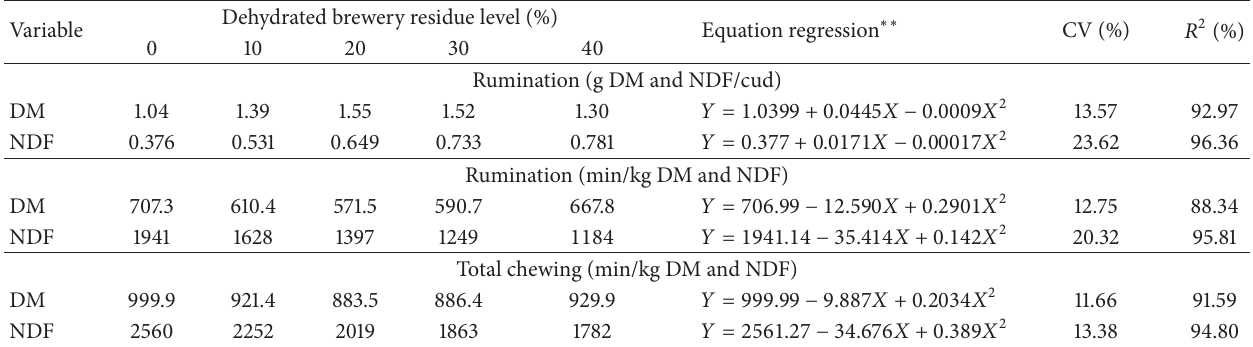
Table 5: Time spent in rumination (g DM and NDF/bolus), rumination (min/kg DM and NDF), and total chewing (min/kg DM and NDF) of ovine fed with marandu grass silage.